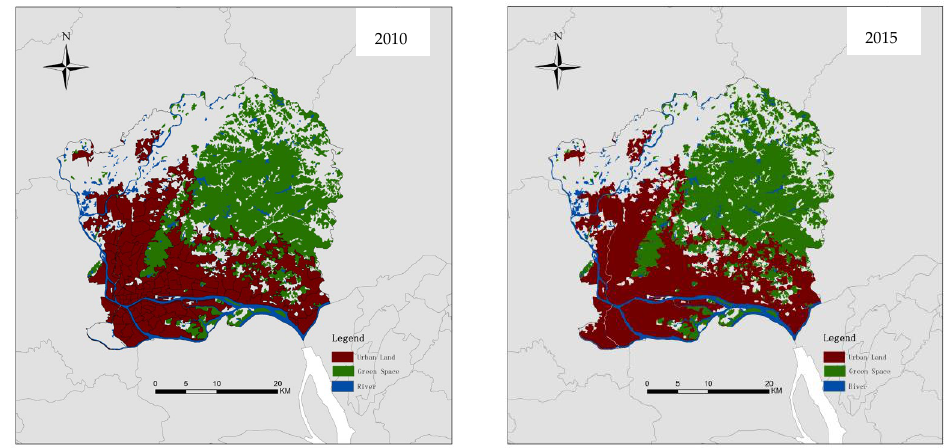
Figure 13. Urban expansion from 2010 to 2015. (Source: drawn by the authors).